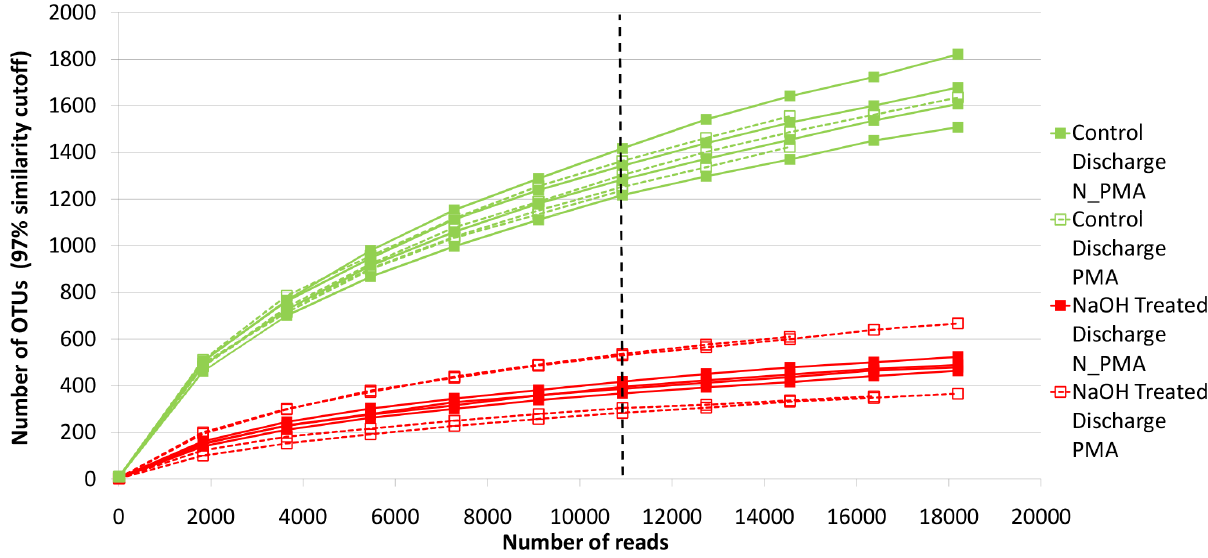
Figure 1. The rarefaction curve of Ion Torrent sequence data. OTUs were defined at 97% similarity cutoff. The figure depicts the comparison between control discharge and NaOH treated discharge samples. The breaking line was placed at around 11,000 (10,918) reads and OTUs were compared across samples when samples were rarefied at 11,000 (10,918) reads.